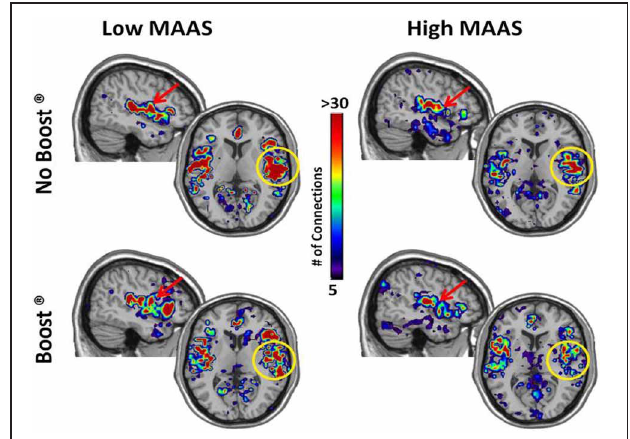
FIGURE 6 | Connectivity Maps from Amygdala by MAAS Category. This figure shows brain regions that are two steps removed from the amygdala. The insula/auditory cortex on the right is highlighted by the yellow